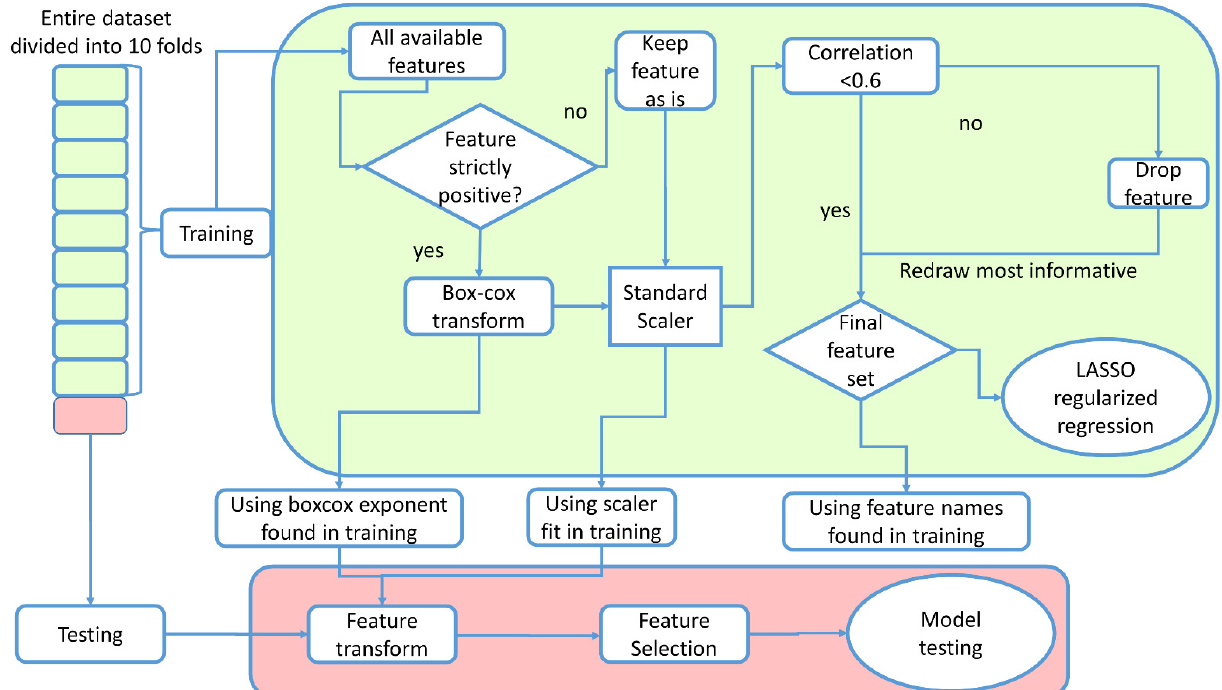
Figure 1. Representation of the 10-fold cross-validation approach used for the training and testing of a single feature group classifier. The input family was selected before entering the green box.